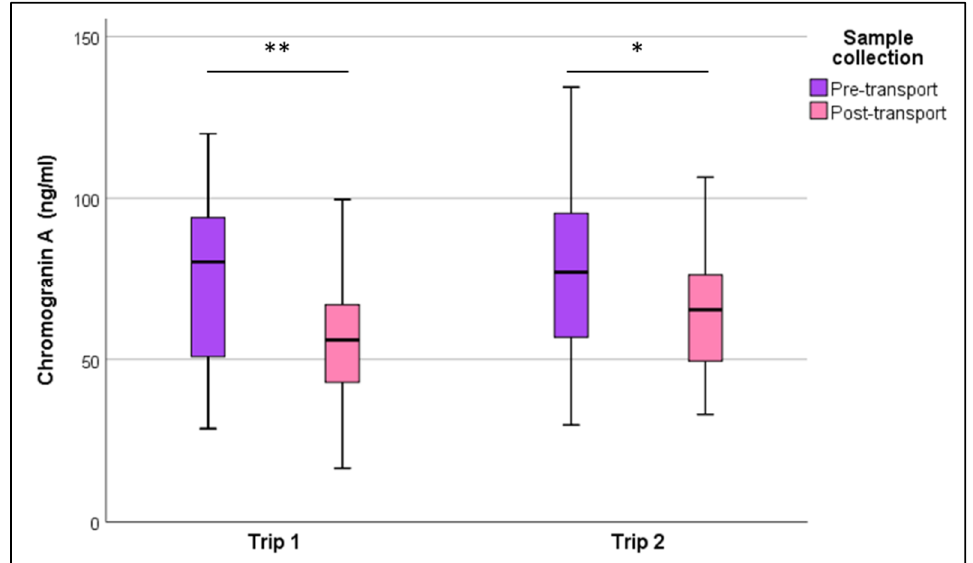
Figure 1. Chromogranin A (ng/mL) pre- and post-transportation drawn in a box plot for both trips; lines extending from the whiskers indicate the variability outside the upper and lower quartiles.